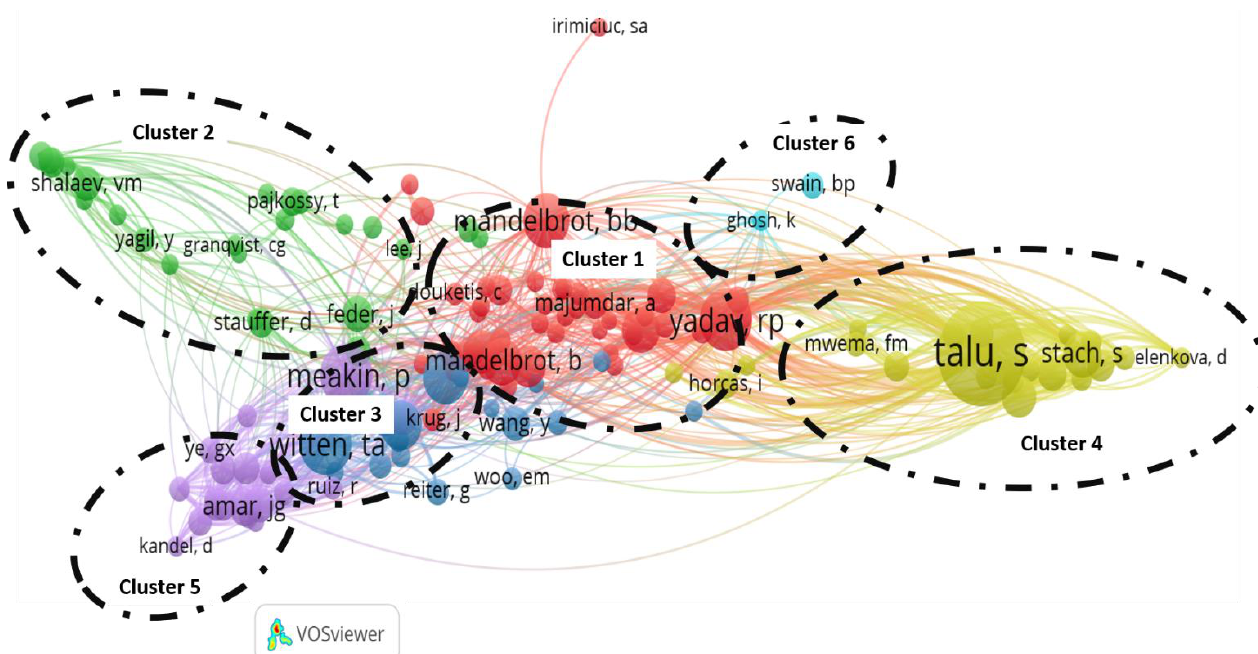
Figure 10. Mapping of co-citation of authors in fractal theory and thin film depositions. A minimum number of citations for each author is 20.